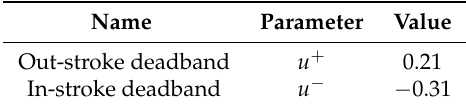
Table 4. Identified deadbands for the knuckle boom